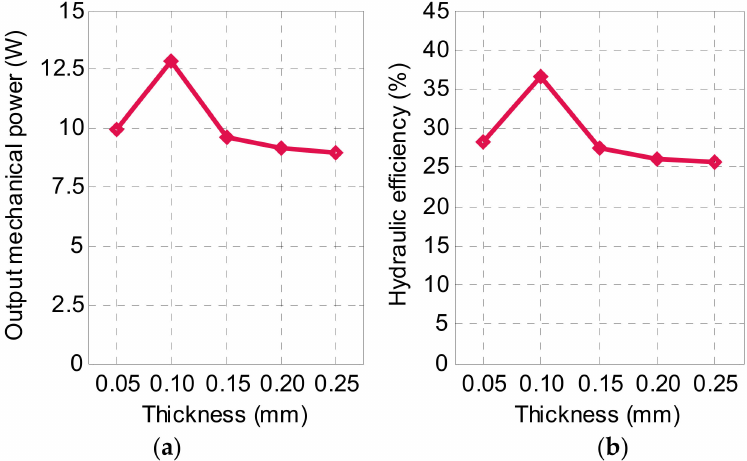
Figure 17. Numerical simulation results of double-layer absorber: ( a ) Output mechanical power; ( b ) Hydraulic e ffi